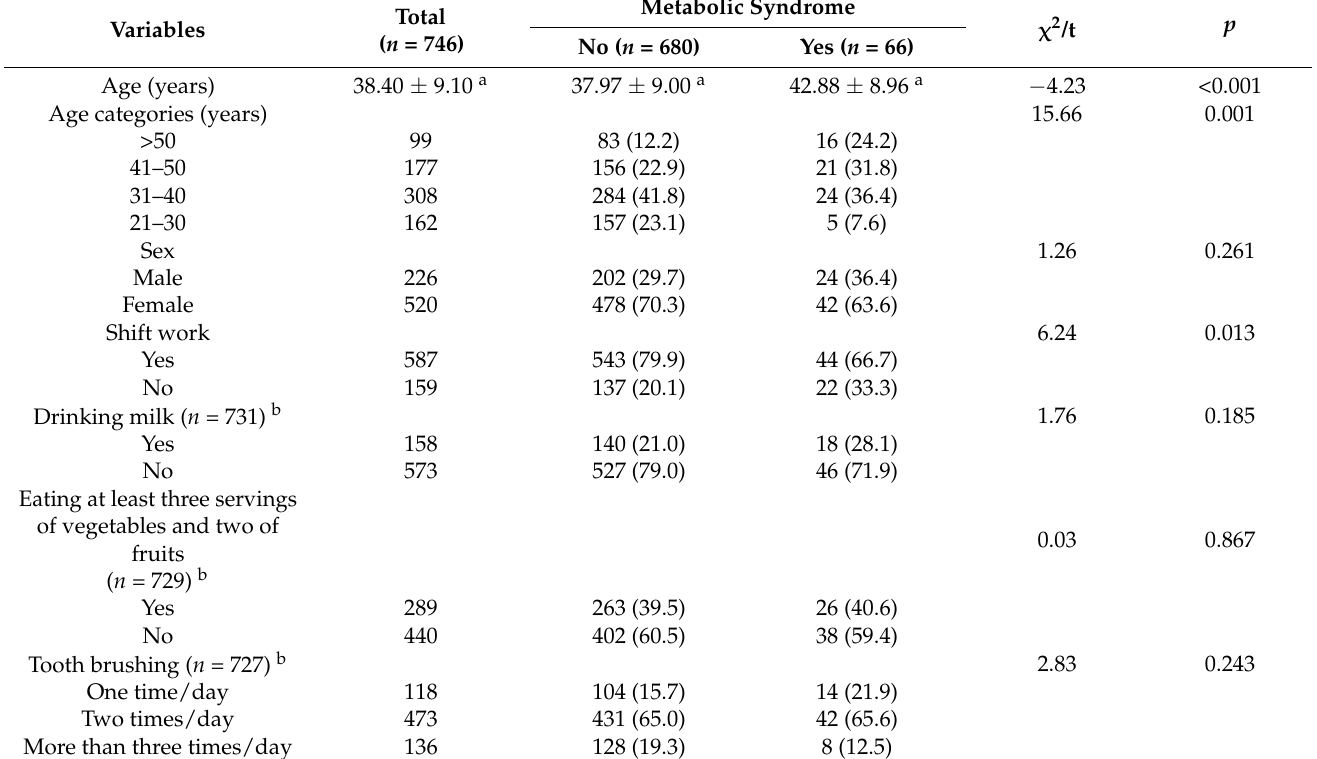
Table 1. Characteristics of hospital staff with and without metabolic